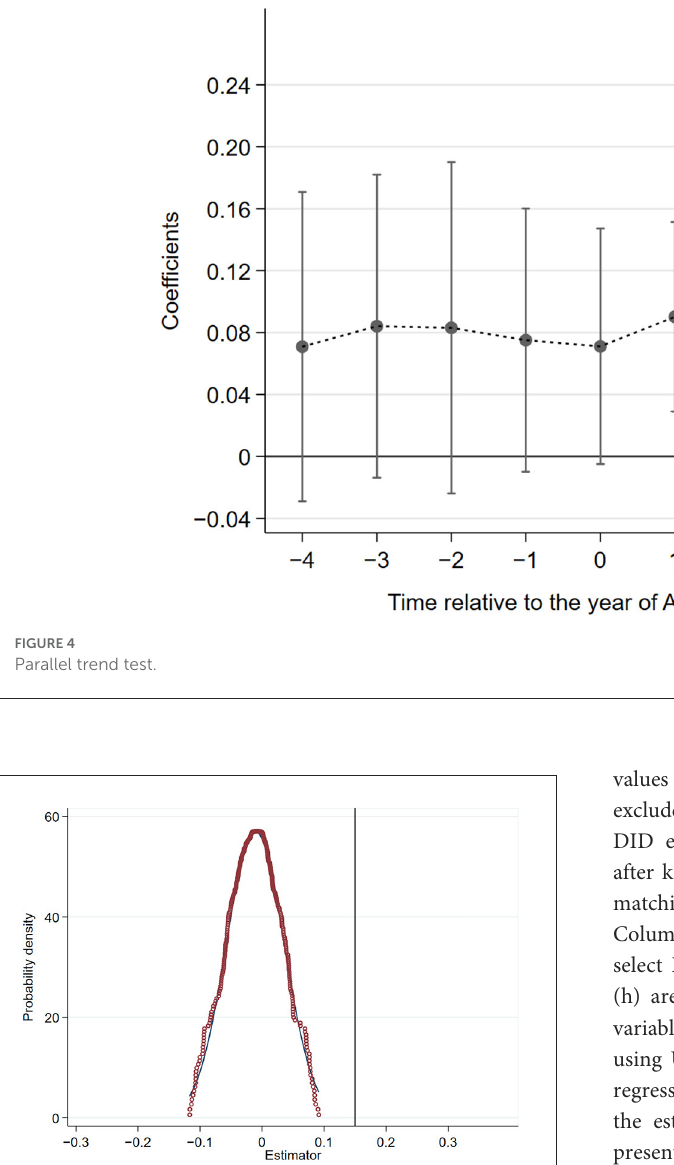
FIGURE5 Placebo